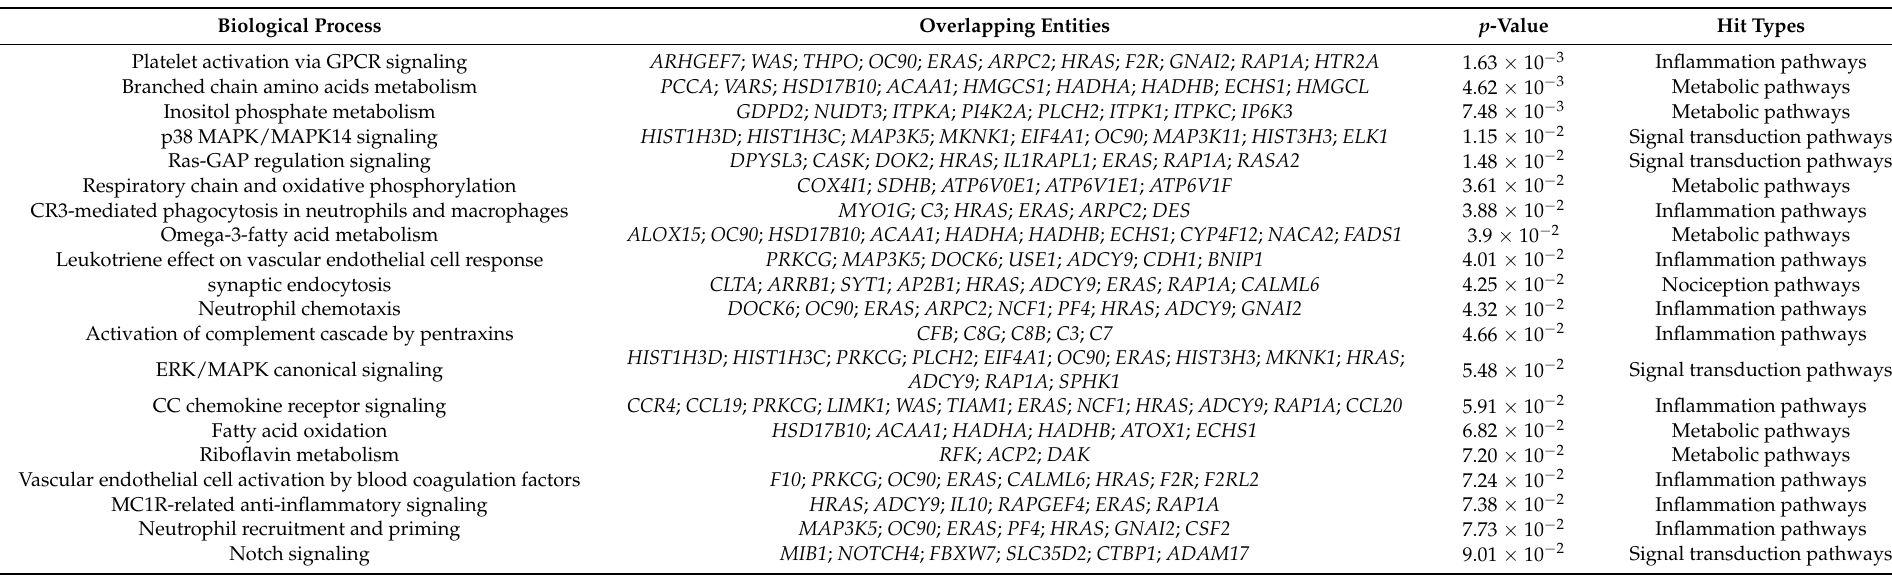
Table 5. A list of statistically significant biological processes in age group 40 as compared to age group 30 ( p < 0.05, FDR), sorted according to the p -value by Fisher’s exact